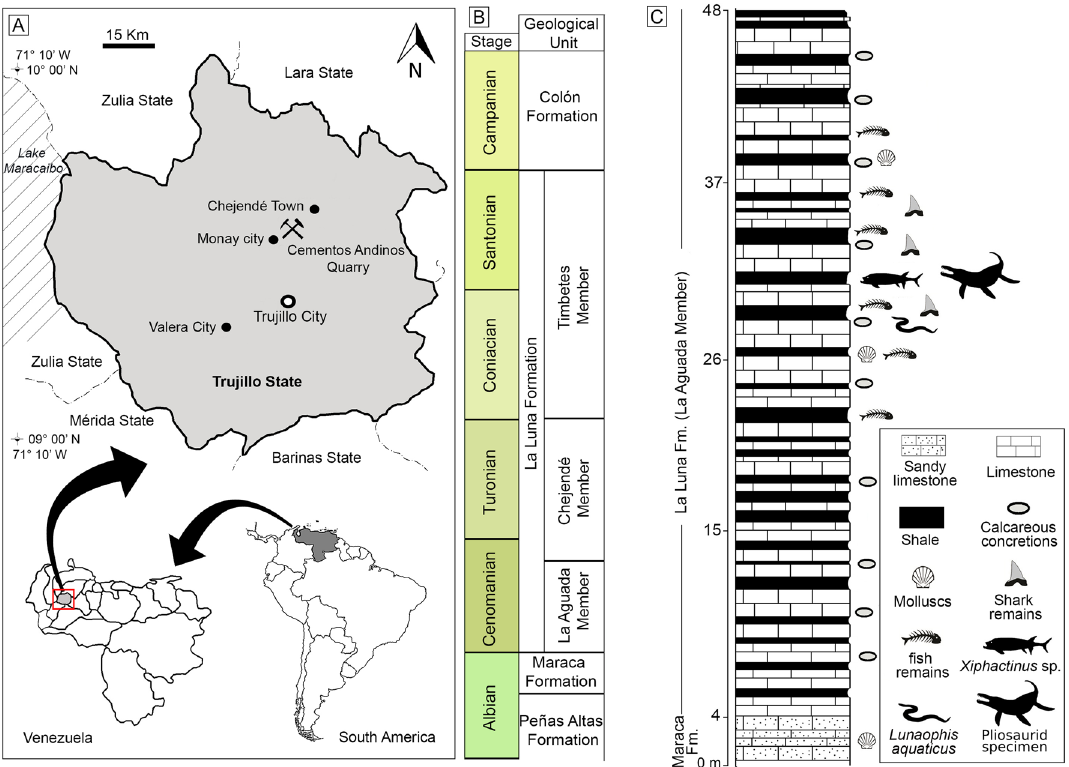
Figure 1. Location and geology of the “Cementos Andinos” quarry, Trujillo state, western Venezuela. ( A ) Location map. ( B ) Cretaceous lithostratigraphic units of the Chejendé region, near Monay city, Trujillo State (modified after 38,39 ). ( C ) Stratigraphic section of the uppermost Maraca Formation and the La Aguada Member (La Luna Formation) in the “Cementos Andinos” quarry (modified by Jorge D. Carrillo-Briceño after 37,40 and using Adobe Illustrator & Photoshop